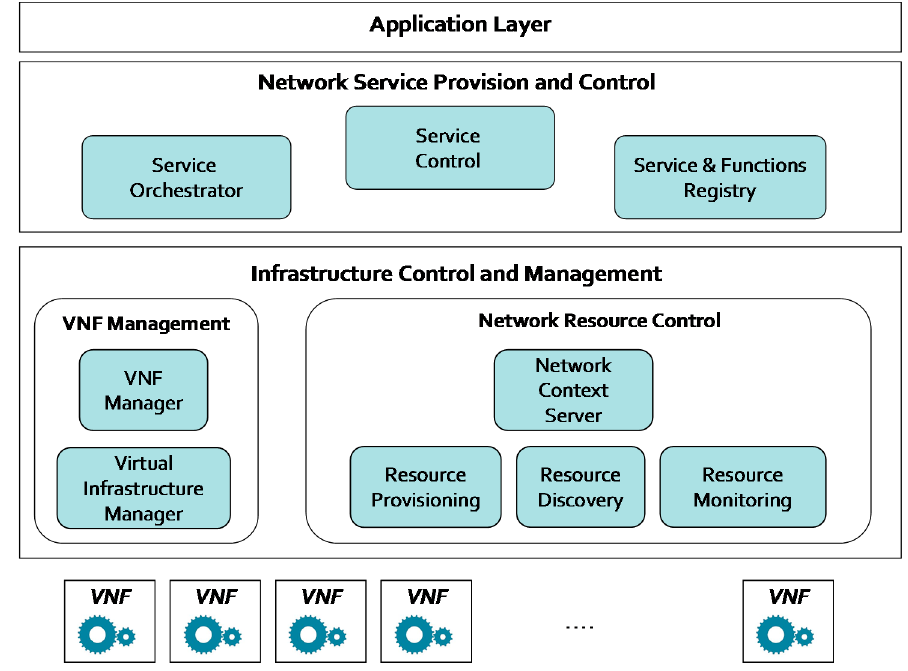
Figure 4. Functional architecture for adaptive service composition and delivery.